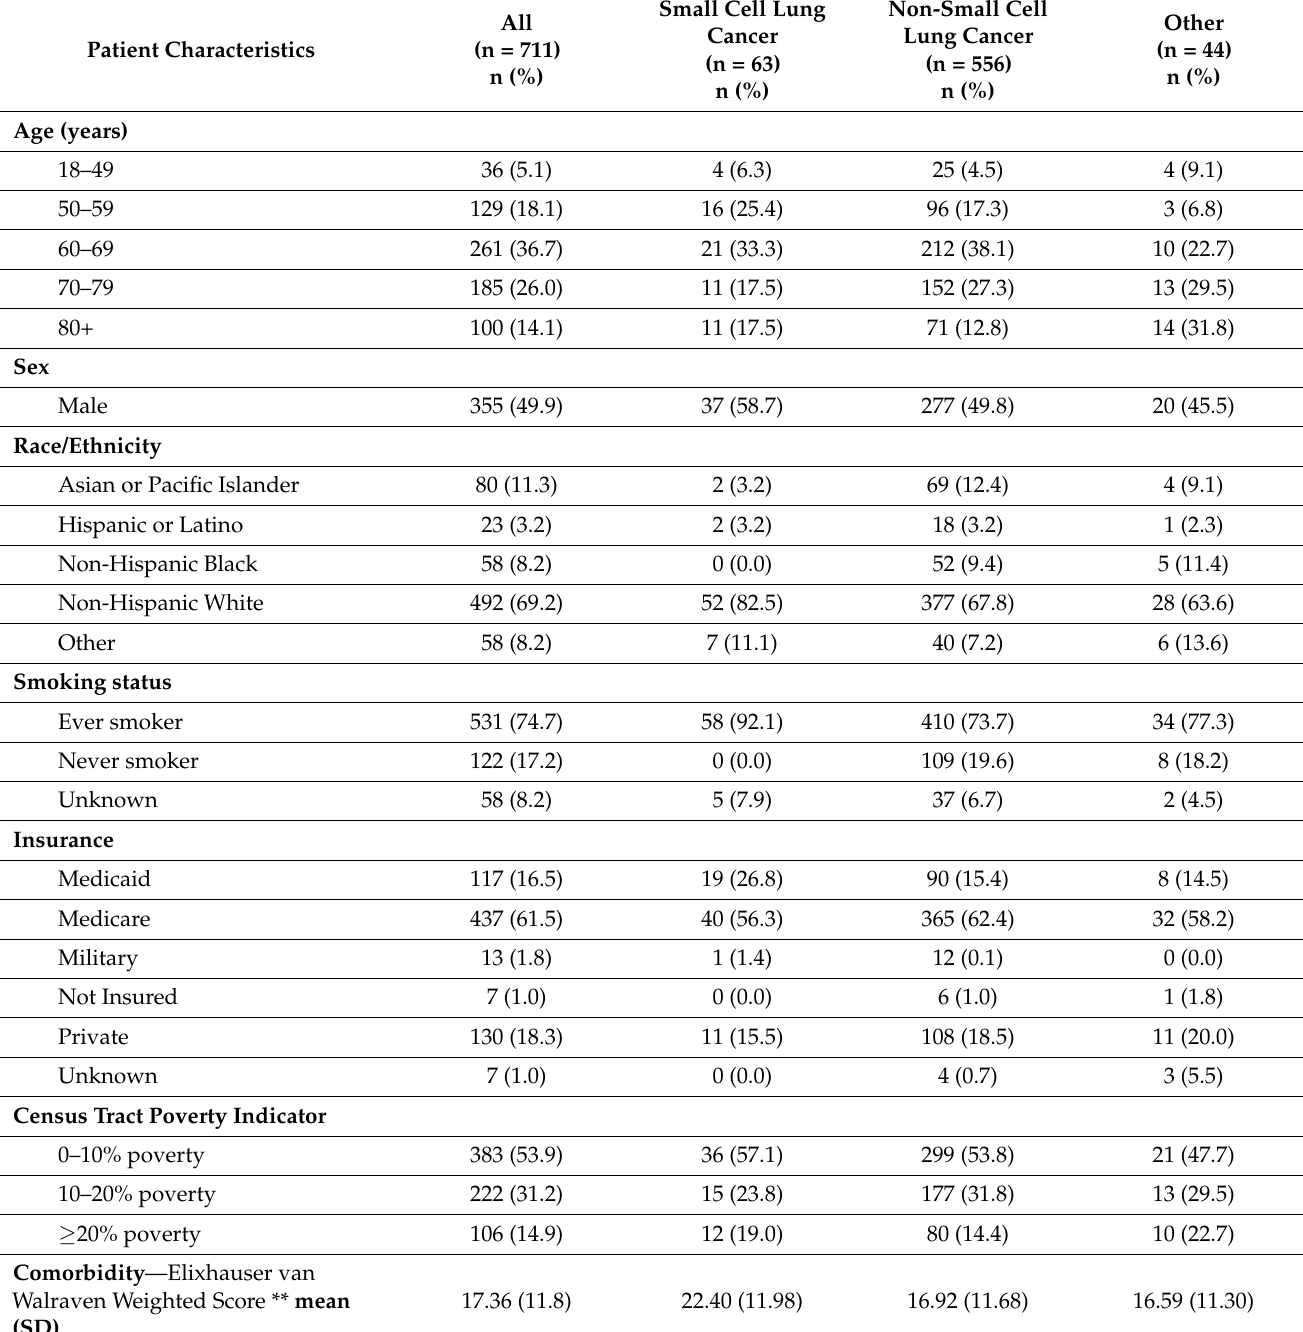
Table A2. Characteristics of patients at time of diagnosis by type of lung